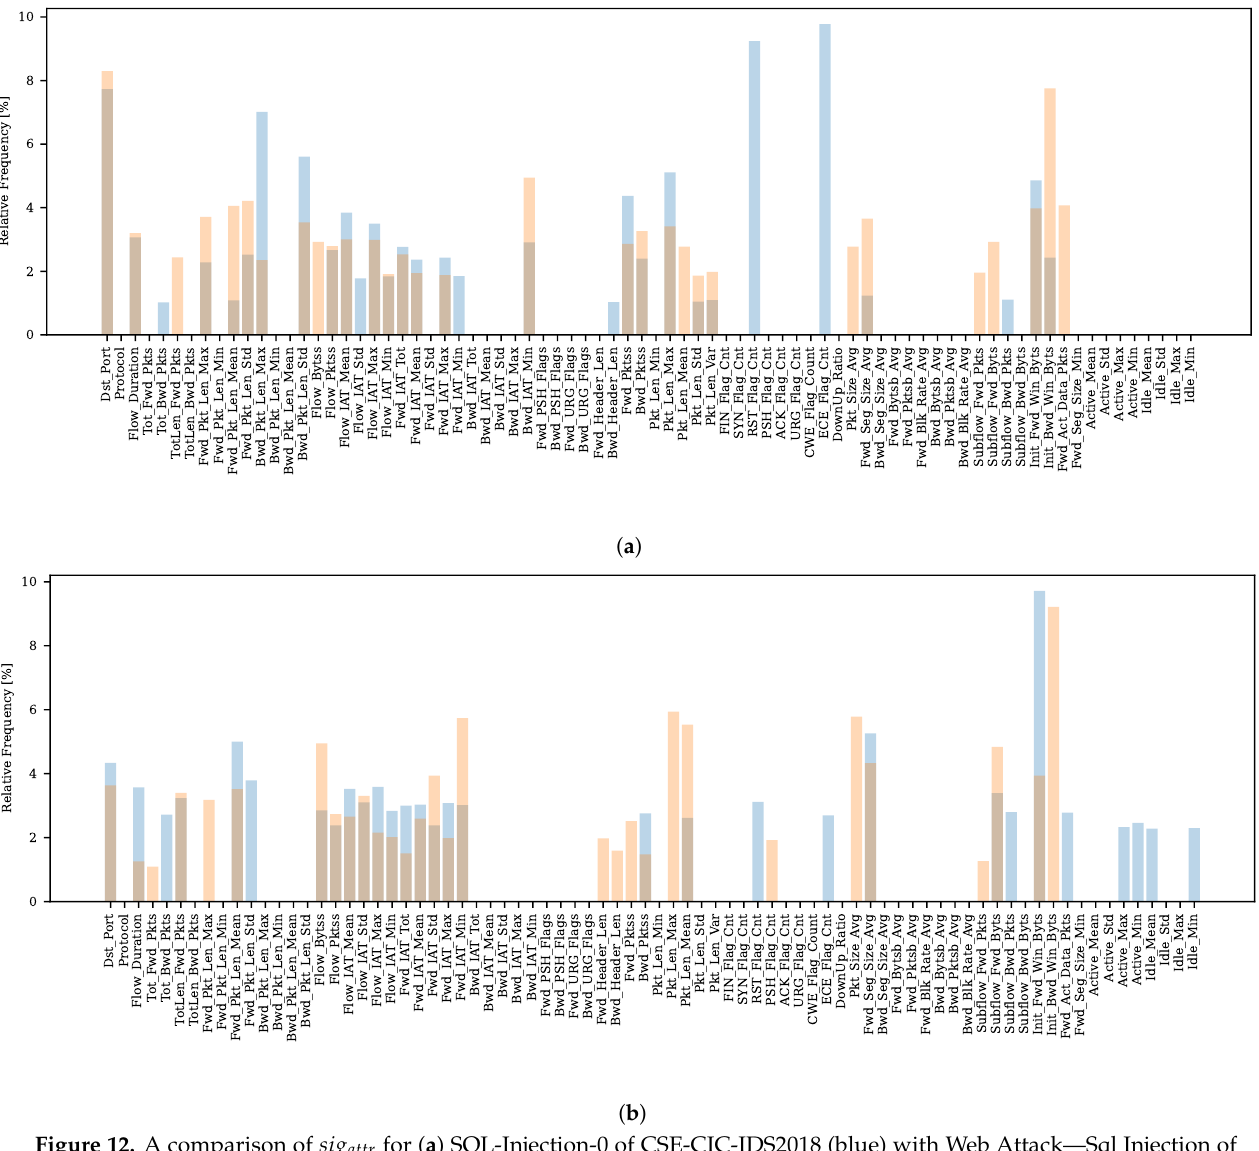
Figure 12. A comparison of sig attr for ( a ) SQL-Injection-0 of CSE-CIC-IDS2018 (blue) with Web Attack—Sql Injection of CICIDS2017 (orange) and ( b ) Brute-Force-Web-1 of CSE-CIC-IDS2018 (blue) with Web Attack—Brute Force of CICIDS2017 (orange) for γ =